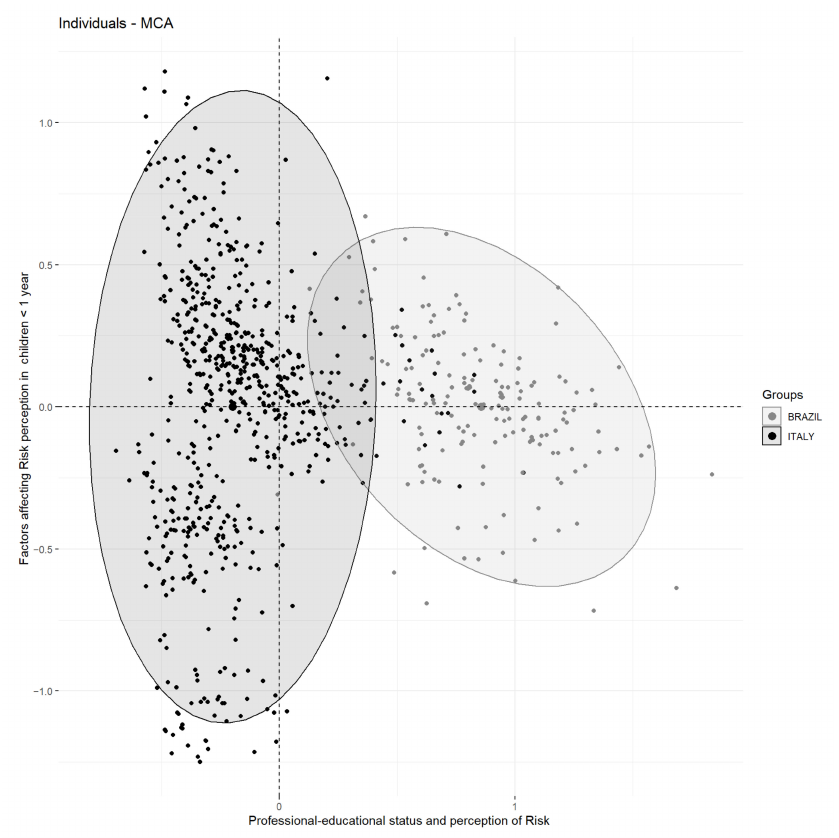
Figure 1. MCA individual biplot for dimensions 1 ( x -axis) and 2 ( y -axis), according to the children’s country of origin (Italy vs.